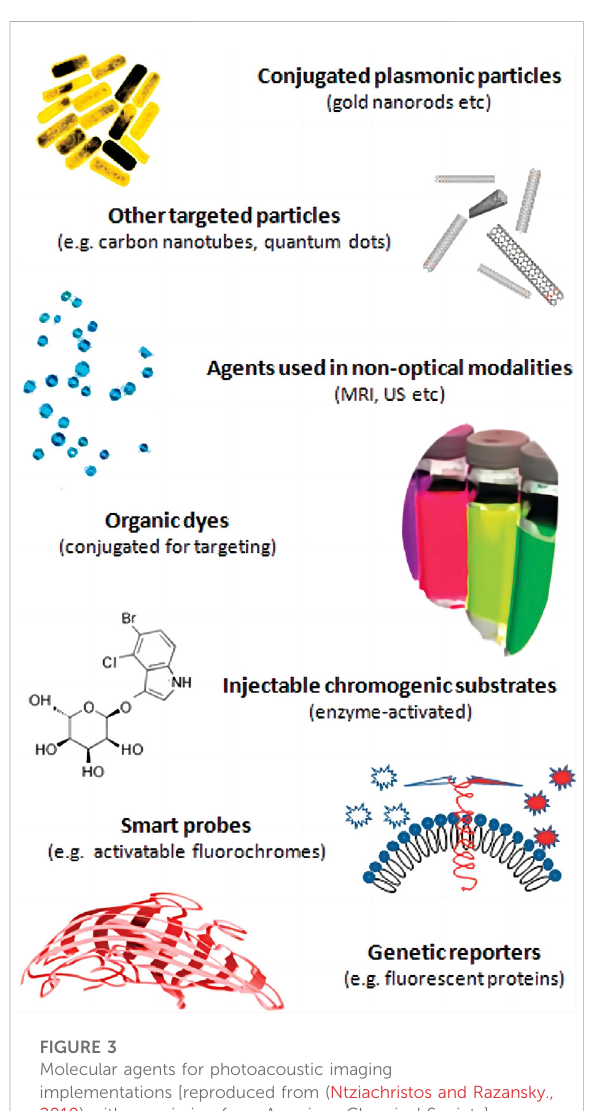
FIGURE 3 Molecular agents for photoacoustic imaging implementations [reproduced from (Ntziachristos and Razansky., 2010) with permission from American Chemical